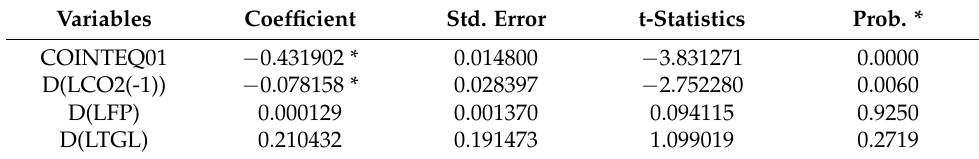
Table 8. Results of ARDL-based short-run elasticity estimates (ARDL (2, 1, 1, 1, 1, 1, 1, 1, 1)).